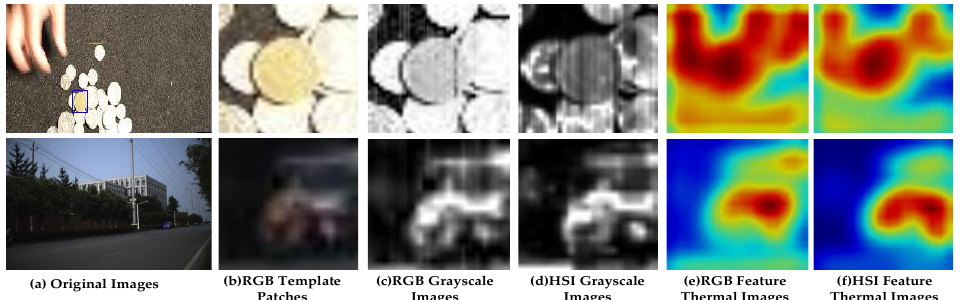
Figure 7. Examples of the reliability of hyperspectral and RGB modality template patches. The blue box in the ( a ) column is the initial position of the object. The top images are the related images of the Coin, and the bottom images are the related images of the Rider2. Among them, two images of the ( a ) column are original images, and that of the ( b ) column displays the RGB template patches. In addition, columns ( c , d ) are grayscale images of RGB and hyperspectral template patches, and columns ( e , f ) are the feature thermal images of RGB and hyperspectral template patches,